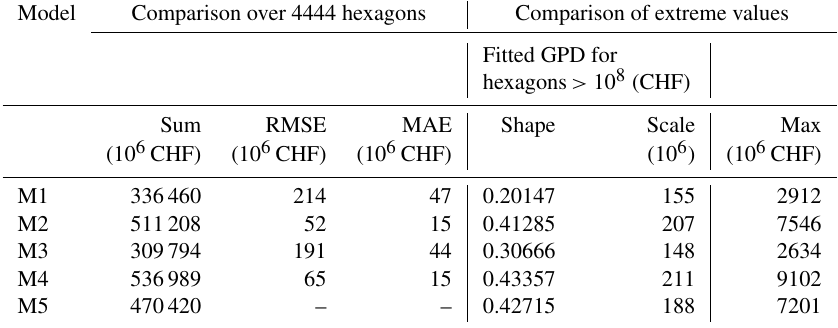
Table 7. Indicators for the comparison of model M1 to M4 with benchmark model M5. Sum represents the sum of exposed-building values over all hexagons, RMSE and MAE represent the root-mean-square error and the mean-absolute error of exposed-building values per hexagon when comparing M1 to M4 with M5. The generalized Pareto distribution (GPD) is fitted for hexagons with exposed-building values higher than 10 8 (CHF), which is equal to the location parameter of the GPD. Shape and scale represent the respective parameter of the fitted GPD. Max represents the highest sum of exposed-building values per